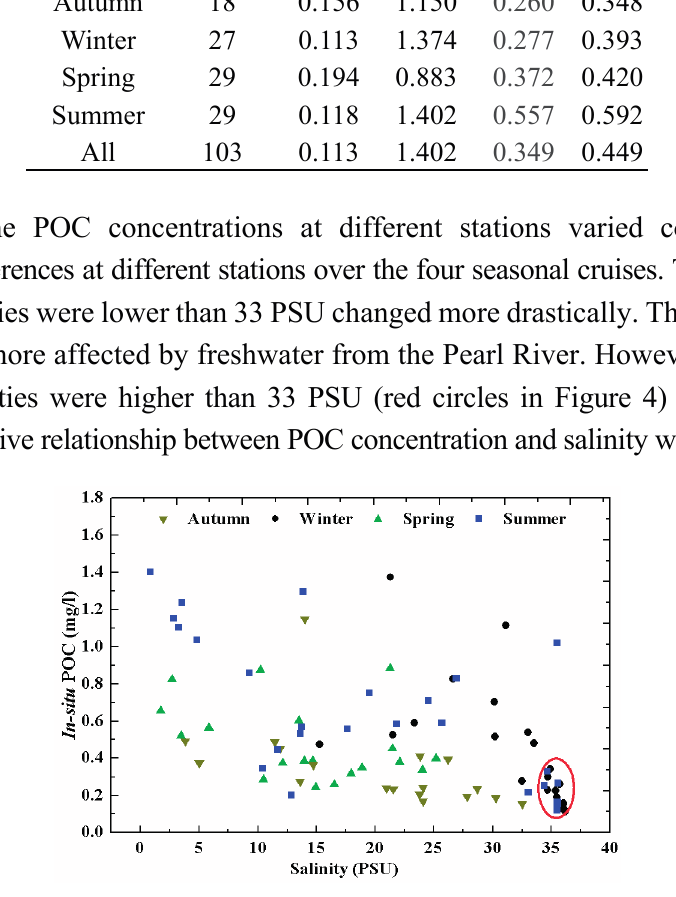
Figure 4. Changes in POC concentrations with salinity (Practical Salinity Units, PSU) in different cruises. Salinity was recorded by a multi-parameter water quality monitor (SBE 19Plus, Sea-Bird Electronics, Inc.: Bellevue, WA,